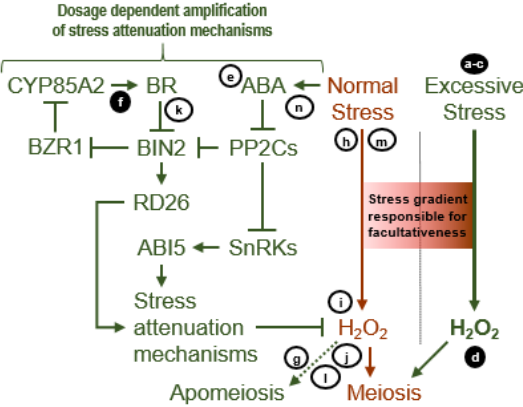
Figure 13. Simplified model of apomixis sex switching in plants. Green text to the left represents enhanced stress attenuation pathways in apomeiotic plants that suppress meiosis under non-stress conditions. The red text represents normal levels of stress attenuation in sexual plants, which are meiosis permissive. Green text to the right represents apomictic plants exposed to excessive stress, which overwhelms stress attenuation mechanisms and induces meiosis. White letters represent experiments that tested metabolic processes of apomeiosis to meiosis switching: a , heat and drought; b , osmotic stress; c , carbon starvation; d , H 2 O 2 ; f , inhibition of brassinosteroid (BR) synthesis by brassinazole. Black numbers represent experiments that tested metabolic processes of meiosis to apomeiosis switching: e , abscisic acid (ABA); g and l , 5-azacytidine (DNA methylation suppression); h ,anoxia(60minemersionpriortopistilculture); i , H 2 O 2 ; j , (S)-2-aminobutane-1,4-dithiolhydrochloride (antioxidant); k , BR; m , glucose; n , fluridone(ABAsynthesissuppression). Arrowsindicateupregulation or activation; blunt end lines represent downregulation or suppression; ABI5, ABA INSENSITIVE 5; BZR1, BRASSINAZOLE-RESISTANT 1; BIN2, BRASSINOSTEROID-INSENSITIVE 2; CYP85A2, BRASSINOSTEROID-6-OXIDASE 2; PP2Cs, protein phosphatase 2Cs; RD26, RESPONSIVE TO DESICCATION 26; SnRKs, sucrose non-fermenting related protein